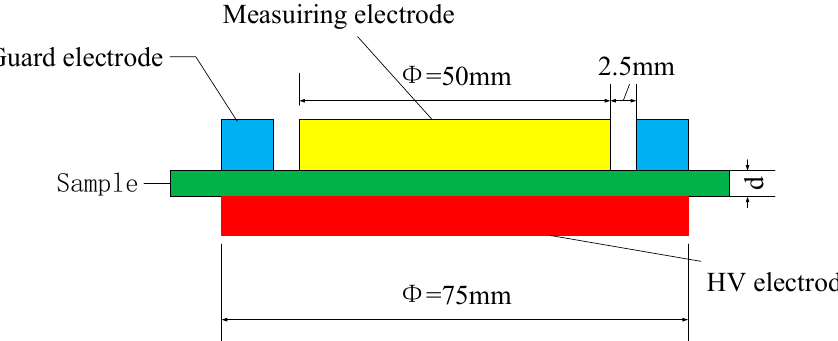
Figure 5. Configuration of the electrode system for conduction current measurement. d is the thickness of the sample.